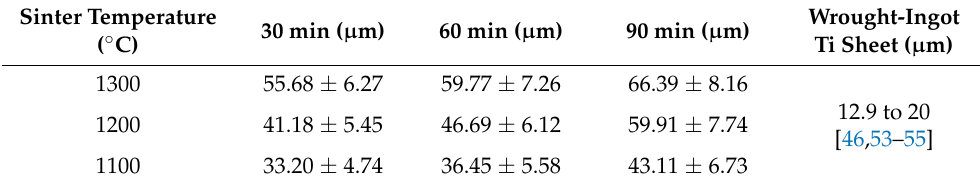
Table 6. The grain size of the sintered titanium strips. Sinter